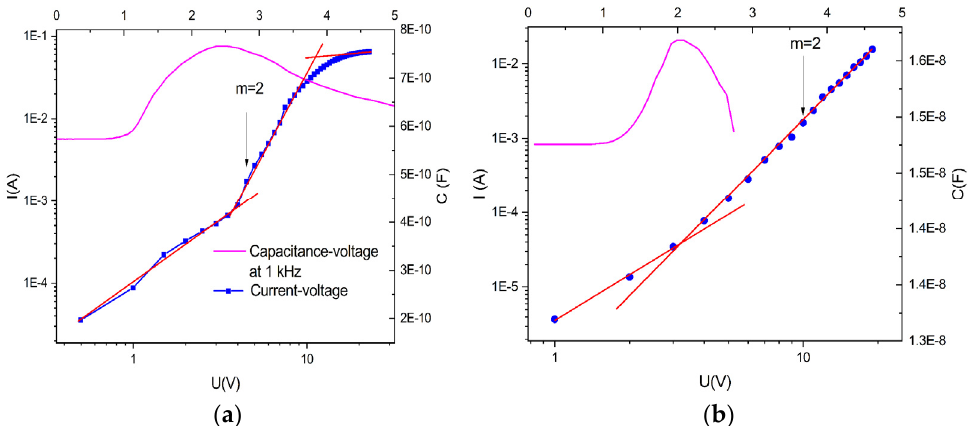
Figure 5. Capacitance–voltage and current–voltage curves in log–log scale of the: ( a ) electrospun devices; ( b ) neat film devices.